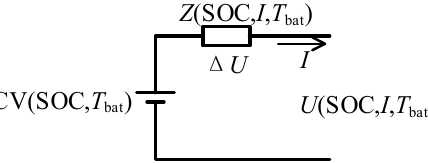
Figure 1. An equivalent circuit model (ECM) of batteries.